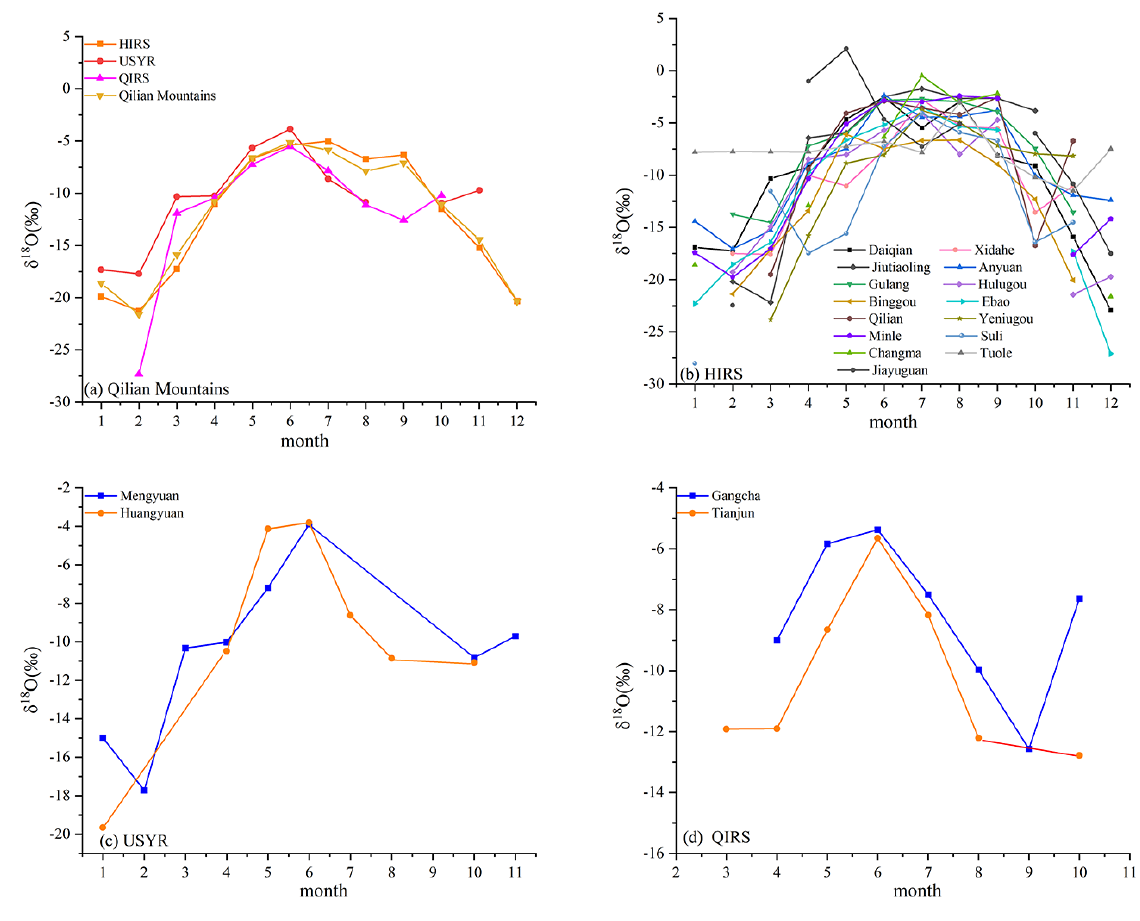
Figure 2. Temporal variation of δ 18 O in precipitation in the Qilian Mountains.